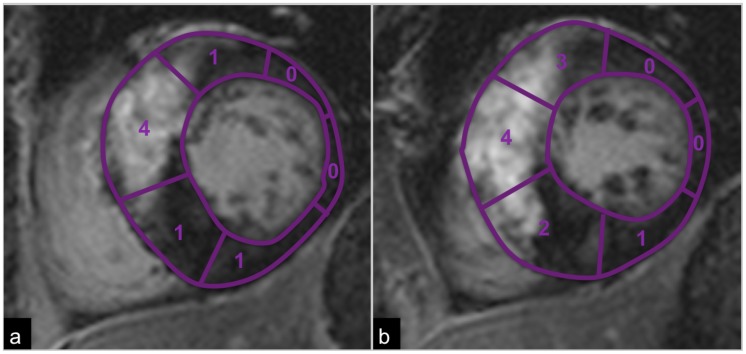
Semiquantitative evaluation of LGE.LGE was scored semiquantitatively in each segment based on the percentage area of LGE. Depicted is an example for LGE scoring: 0 = no LGE, 1 = 1–25%, 2 = 26–50%, 3 = 51–75% and 4 = 76–100% LGE.